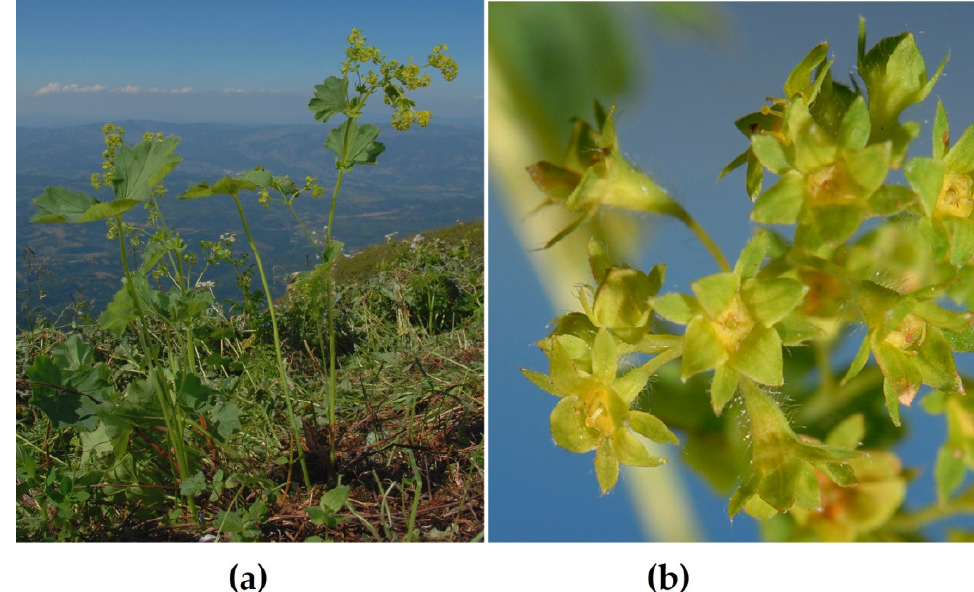
Figure 1. Alchemilla viridiflora Rothm: ( a ) plant at natural habitat; ( b ) magnified flowering parts.